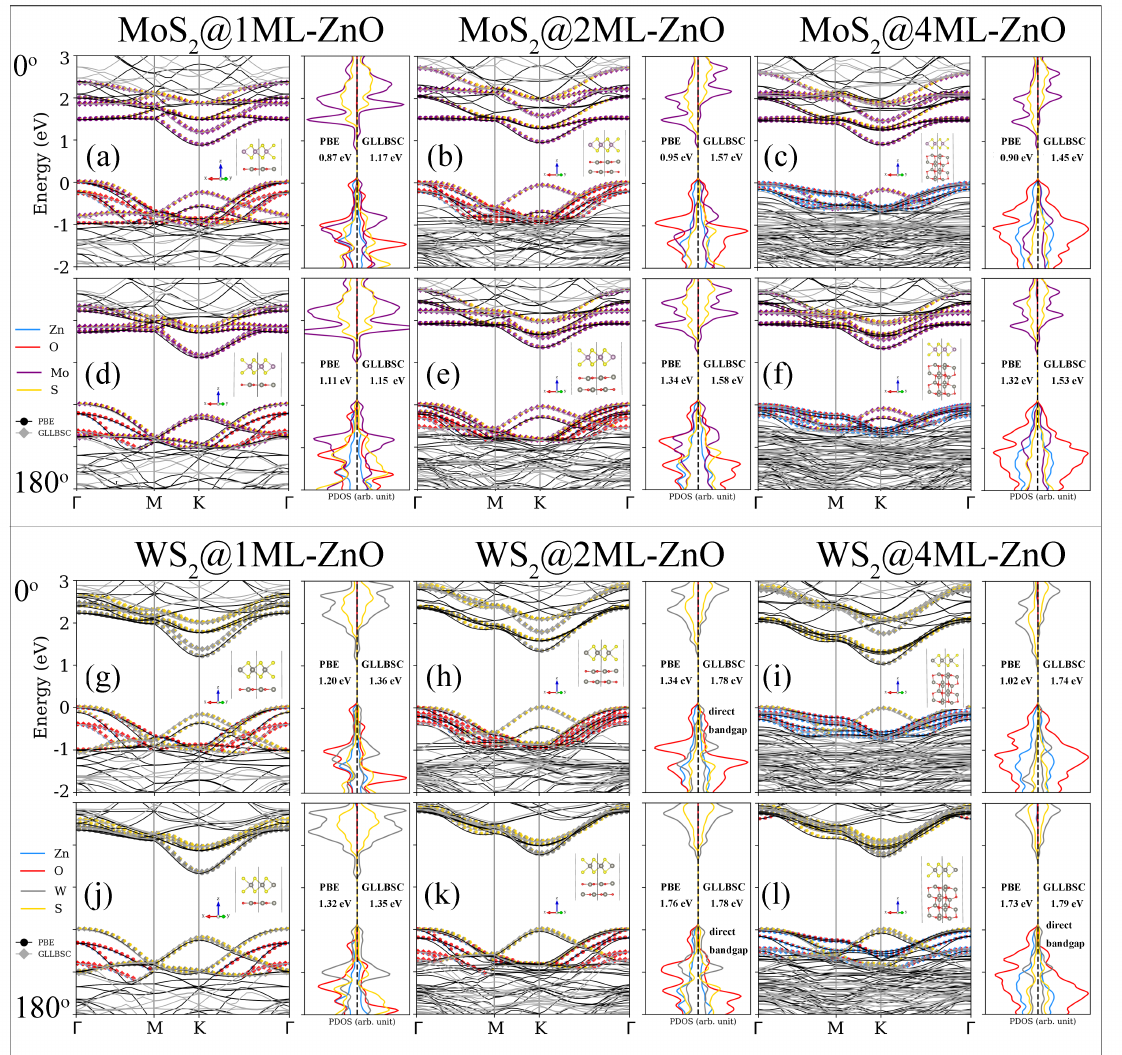
Figure 7. Band structures and projected density of states (PDOS) as calculated for MoS 2 ( a – f ) and WS 2 ( g – l ) deposited at 1ML-, 2ML-, and 4ML-ZnO substrates. Odd rows show the MoS 2 @ZnO (WS 2 @ZnO) with the rotation angle of 0 ◦ , while even rows indicate the MoS 2 @ZnO (WS 2 @ZnO) at 180 ◦ . The insets show the atomic structures of MoS 2 @ZnO and WS 2 @ZnO 2D